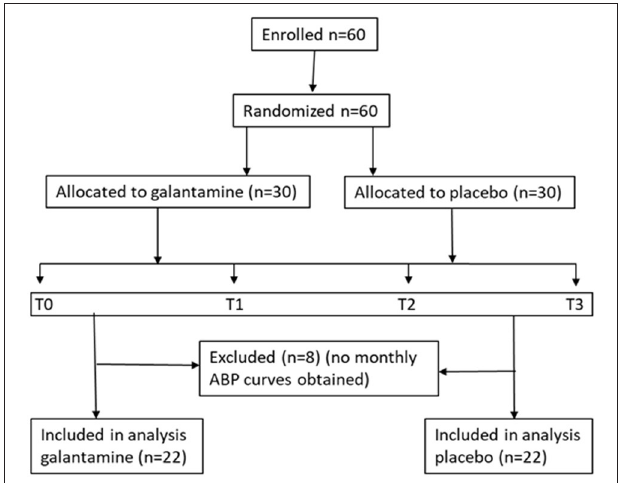
FIGURE 1 | Flow chart (protocol sequence). T0—blood sample draw, blood pressure curve recording; T1 and T2—blood pressure curve recording; T3—blood sample draw, blood pressure curve recording.